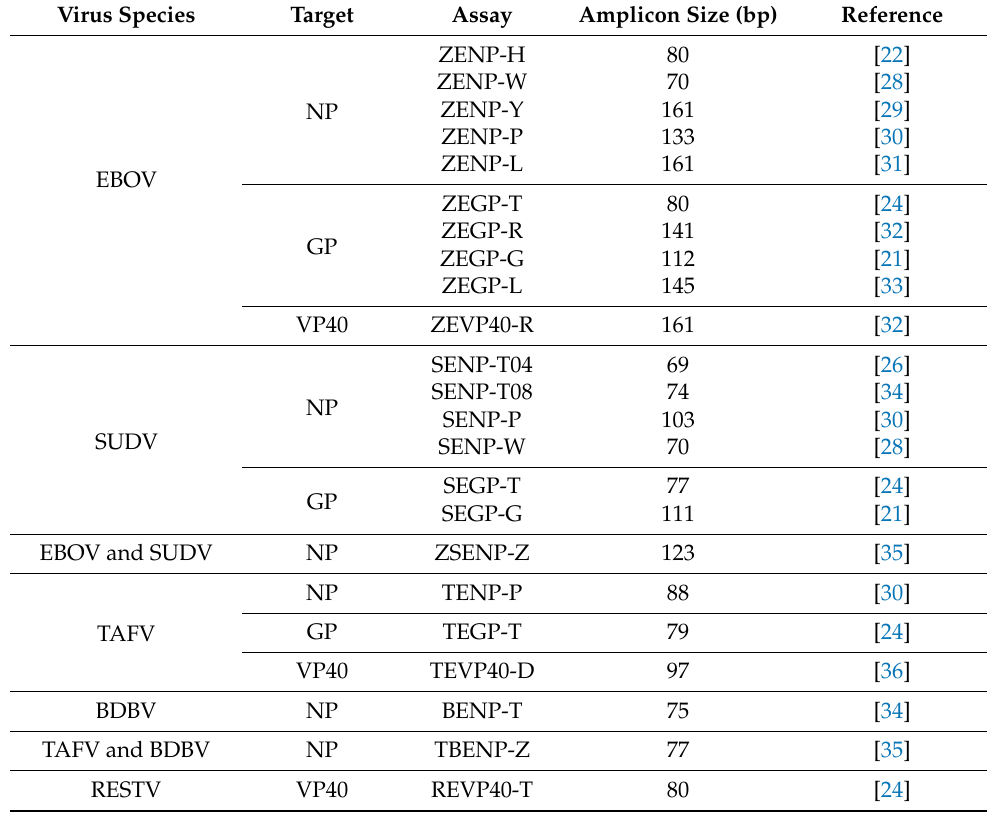
Table 1. Real-time One-step RT-PCR assay